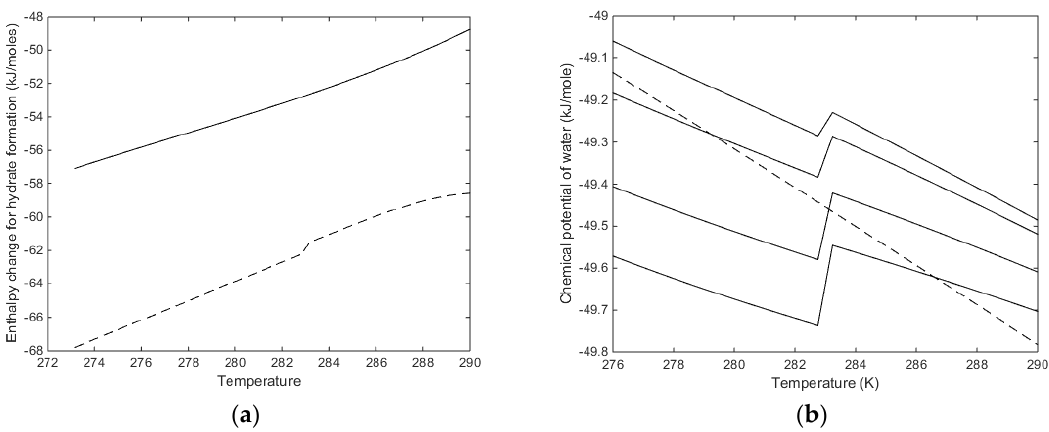
Figure 11. ( a ) Enthalpy of CH 4 hydrate formation (solid) along the hydrate equilibrium curve and enthalpy of CO 2 hydrate formation (dashed) along the hydrate equilibrium curve. ( b ) Chemical potential of liquid water (dashed) at 146 bar as function of temperature. Solid curves are chemical potentials for water in hydrates formed from CO 2 and N 2 mixtures at 146 bars. Lower solid curve is for pure CO 2 , next solid curve is for 70 mole per cent CO 2 , then 40 mole per cent CO 2 and top is for 20 mole per cent CO 2 .